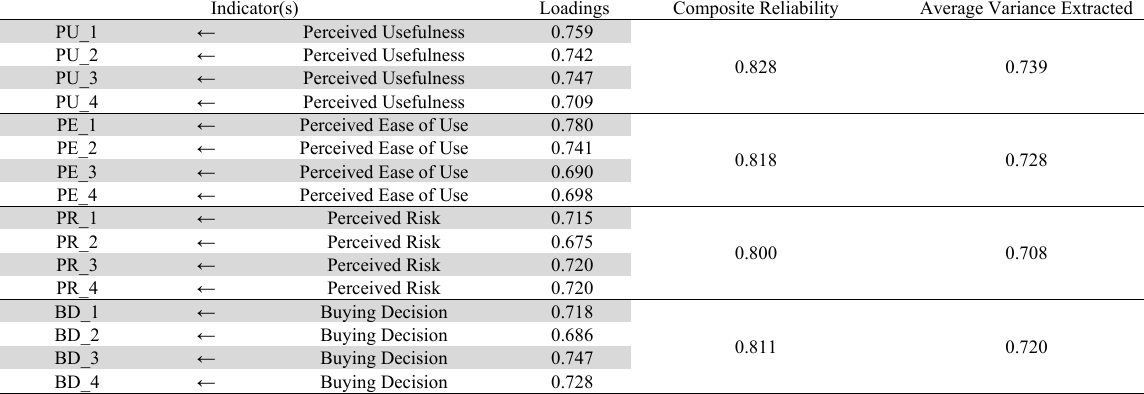
Results of Construct Validity and Reliability